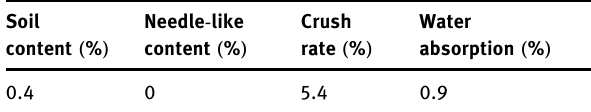
Table 3: Technical indicators of crushed stone Soil